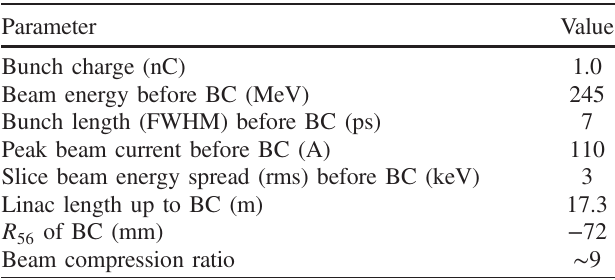
TABLE I. Nominal beam and linac parameters in simulation.